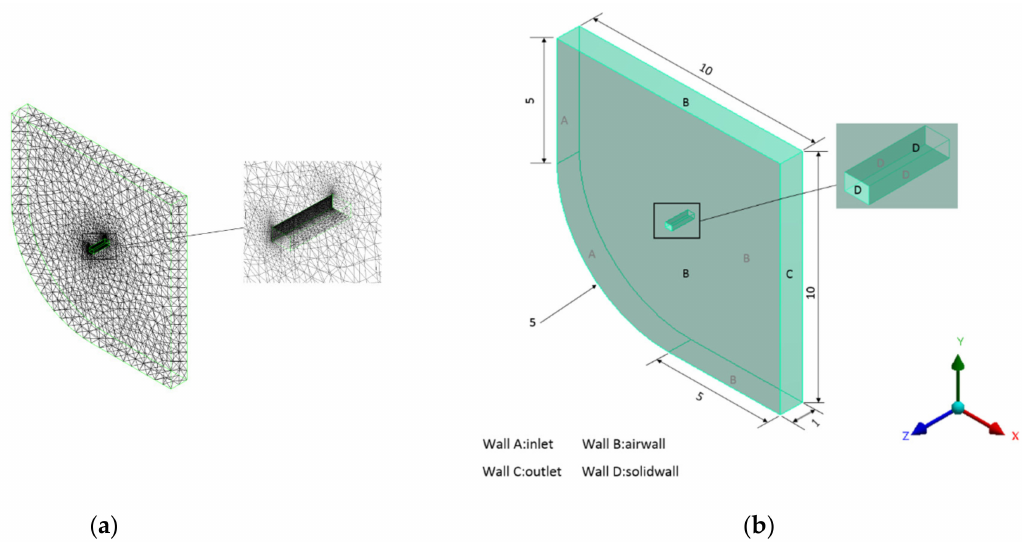
Figure 2. Flow field model. ( a ) Mesh arrangement of flow field model. ( b ) Size of the flow field model and name of the boundaries